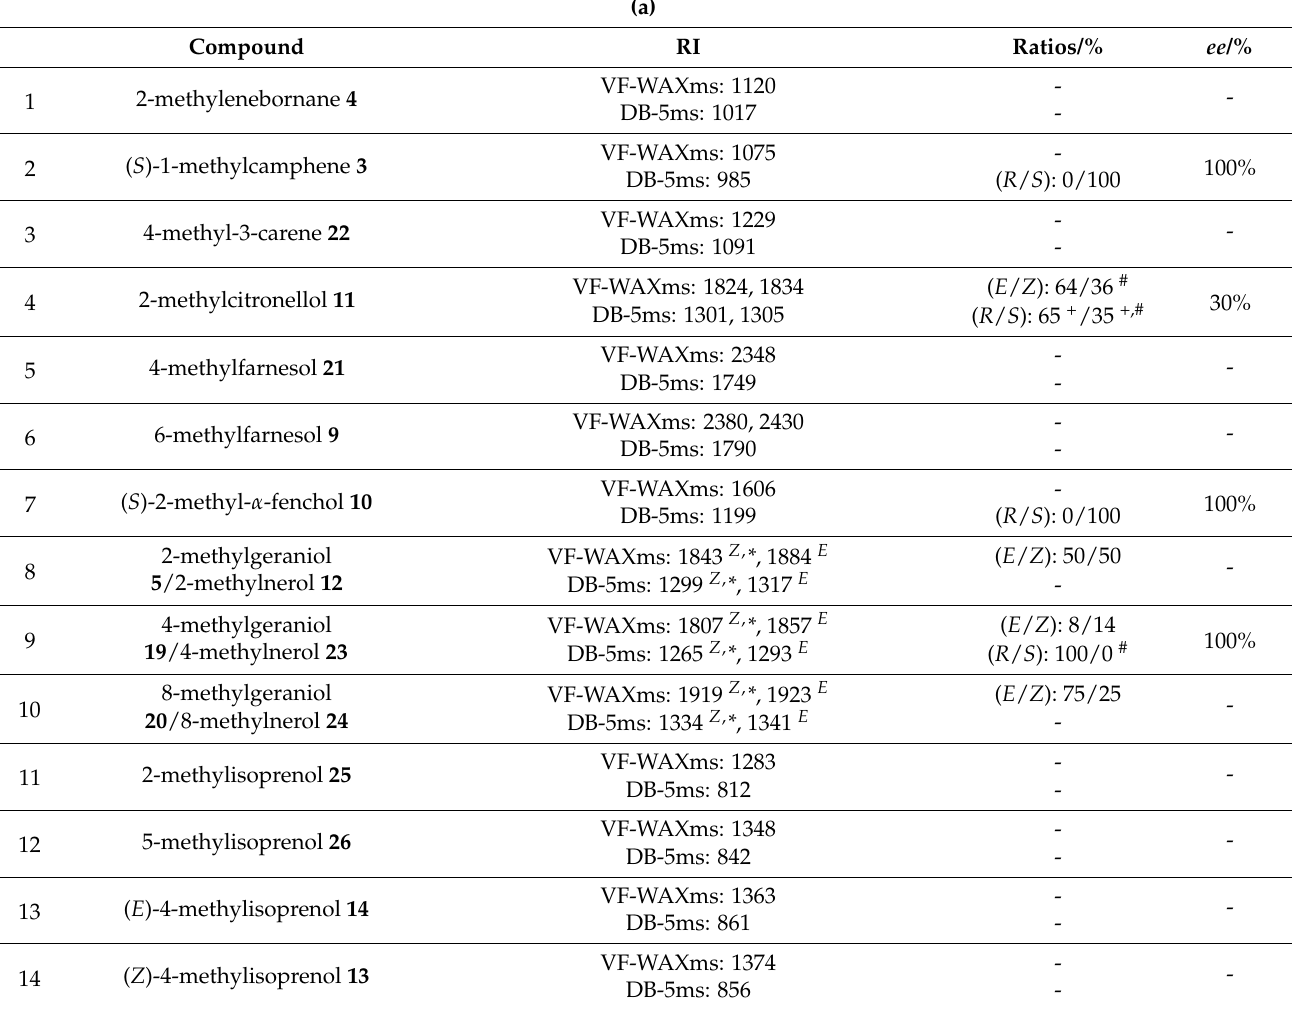
Table 1. ( a ) Retention indices on a polar VF-WAXms column and a nonpolar DB-5ms column, ratios of ( E / Z ) isomers, ratios of ( R )- and ( S )-enantiomers, and enantiomeric excess ( ee ). ( b ) Retention indices on a polar VF-WAXms column and a nonpolar DB-5ms column, ratios of ( E / Z ) isomers, ratios of ( R )- and ( S )-enantiomers, and enantiomeric excess ( ee ). (a)